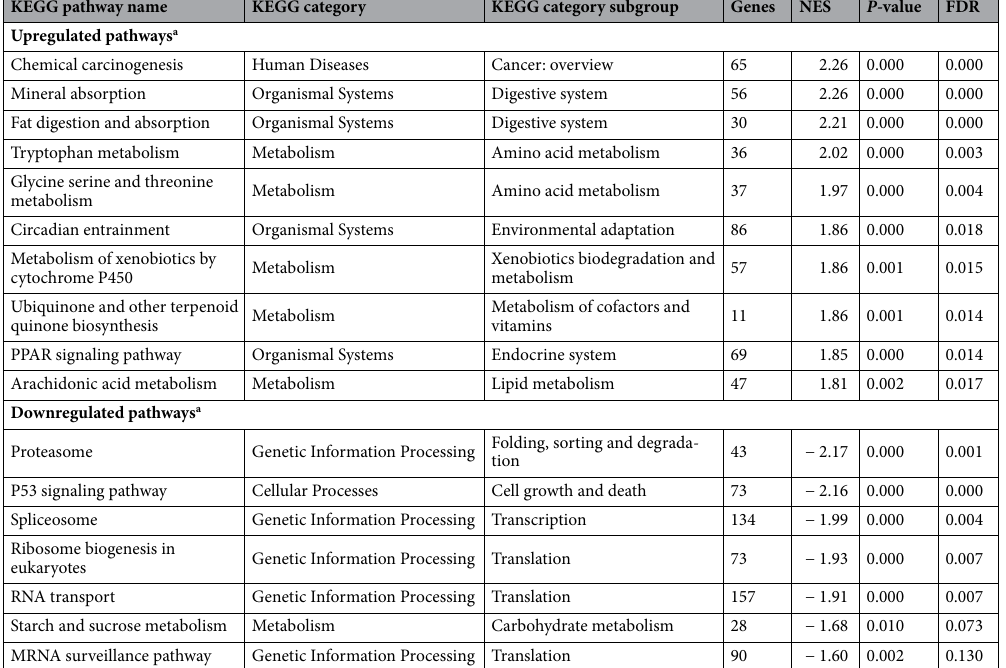
Table 4. Top 10 most enriched (based on NES) up- and downregulated pathways related to the intestine in induced pluripotent stem cell derived intestinal epithelial cell layers exposed to 1 mM butyrate compared with the control. a References indicating their role or relationship to the intestine for the selected pathways are given in the supplementary files; Table